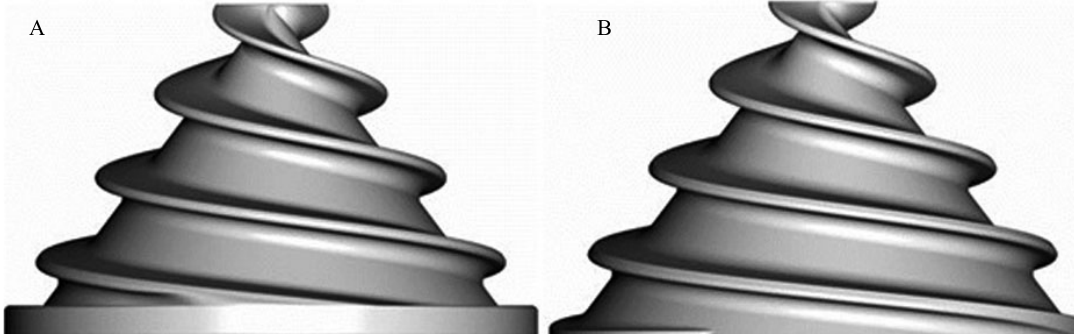
Fig. 2A - First model and 2B - Rotor final model